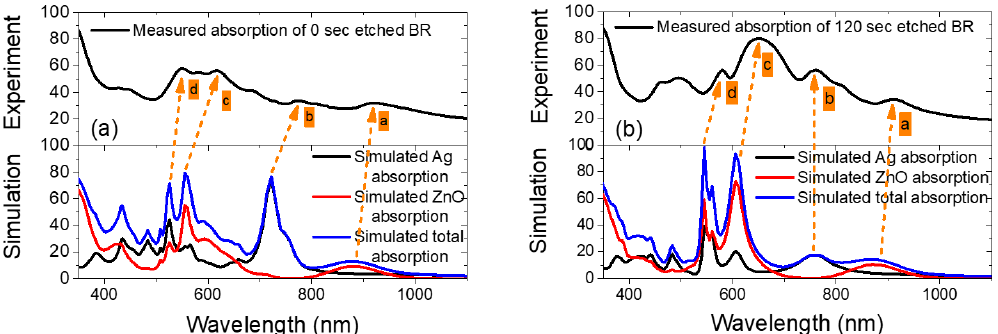
Figure 8. ( a ) 0 s etched BR measured absorption (top) compared with a simulated absorption under 595 nm opening ( D = 595 nm) simulation case; ( b ) 120 s etched BR measured absorption (top)